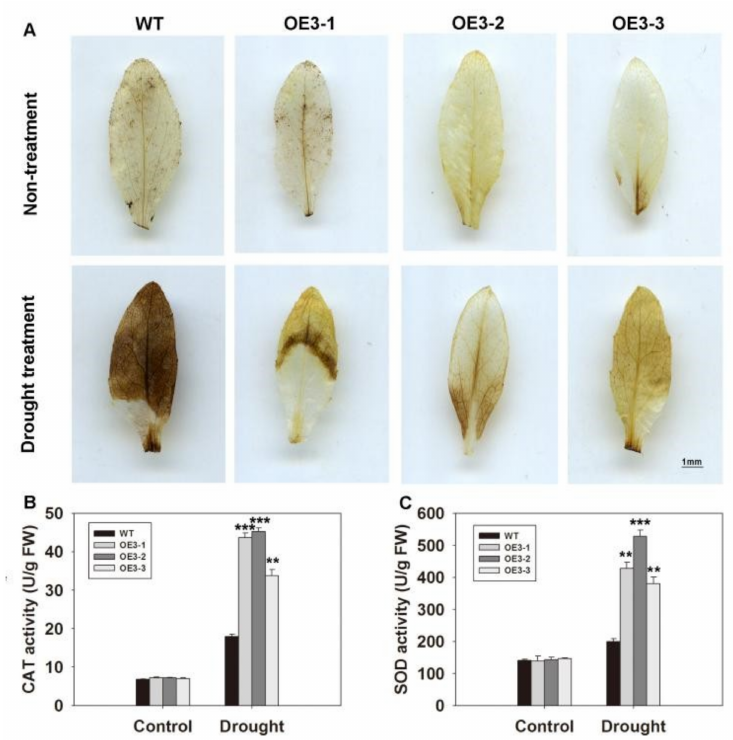
Figure 7. Overexpression of ZmASR3 increases drought tolerance by decreasing H 2 O 2 accumulation and increasing SOD and CAT activities. ( A ) H 2 O 2 accumulation in the three transgenic lines and wild-type plants. Two-week-old Arabidopsis plants had water withheld for 15 days and were analyzed. Scale bar = 1 mm. ( B ) Analysis of CAT activity. ( C ) Analysis of SOD activity. All samples were measured in three independent experiments. For ( B , C ), vertical bars indicate means ± S.E. ( n ≥ 3). Significant di ff erences: ** p < 0.01; *** p <